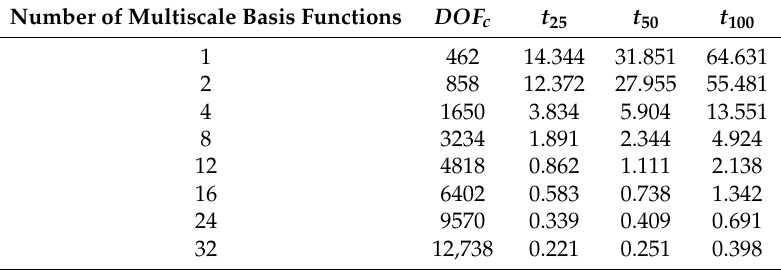
Figure 15. Numerical results for Test 3.RBC . Solutions p and p ms for the final time. Left : Fine-scale solution DOF f = 43,524. Right : Multiscale solution using 32 basis functions DOF c = 12,738. Table 9. Numerical results for Test 3.RBC . Relative L 2 error (%) for different numbers of multiscale basis